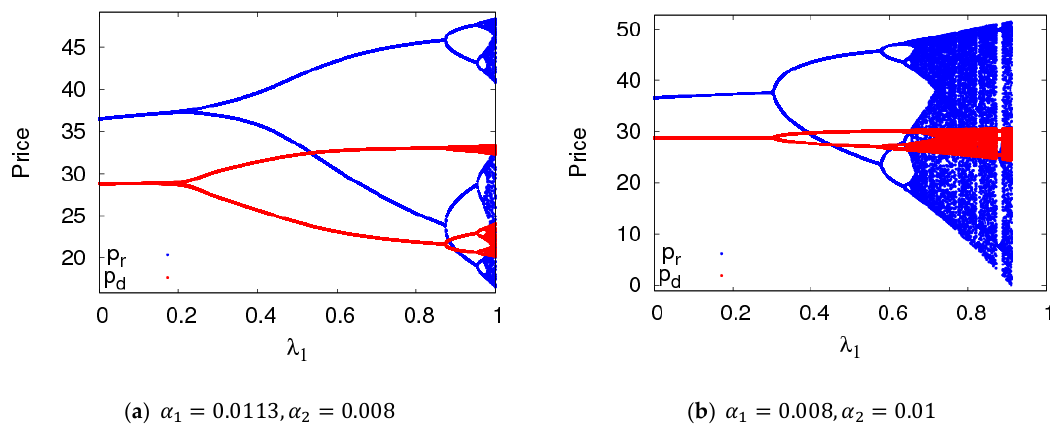
Figure 9. The evolution characteristics of dynamic System (7) when 𝜆 1 ∈ [0,1].